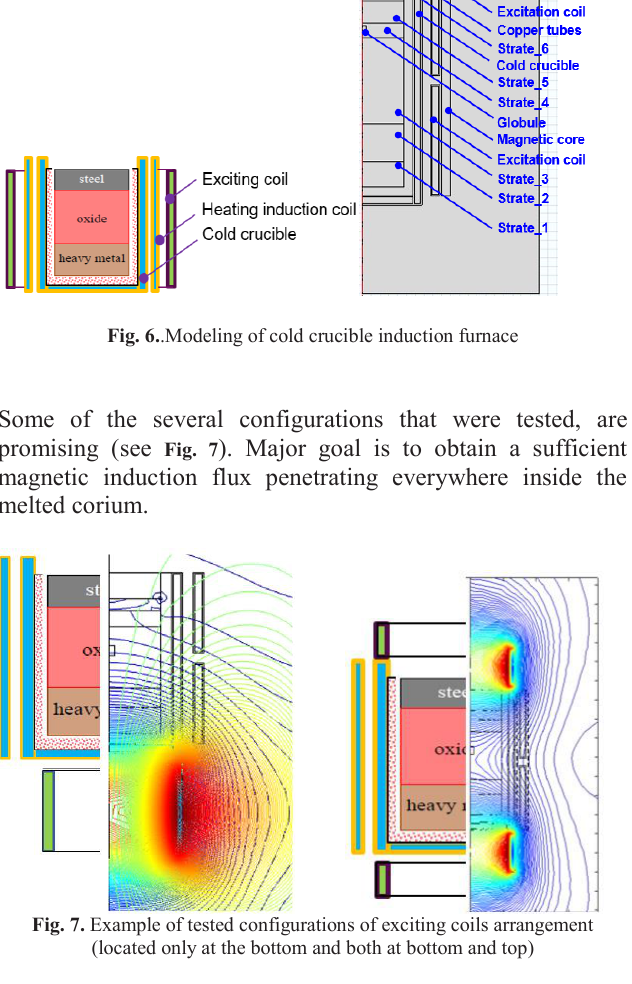
Fig. 1. Reflection of an acoustic wave at the interface between two materials.